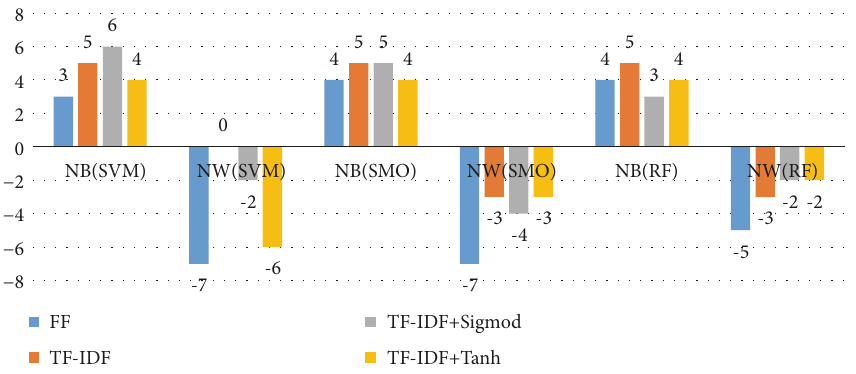
Figure 6: Best and worst number of activity concerning on precision concerning on